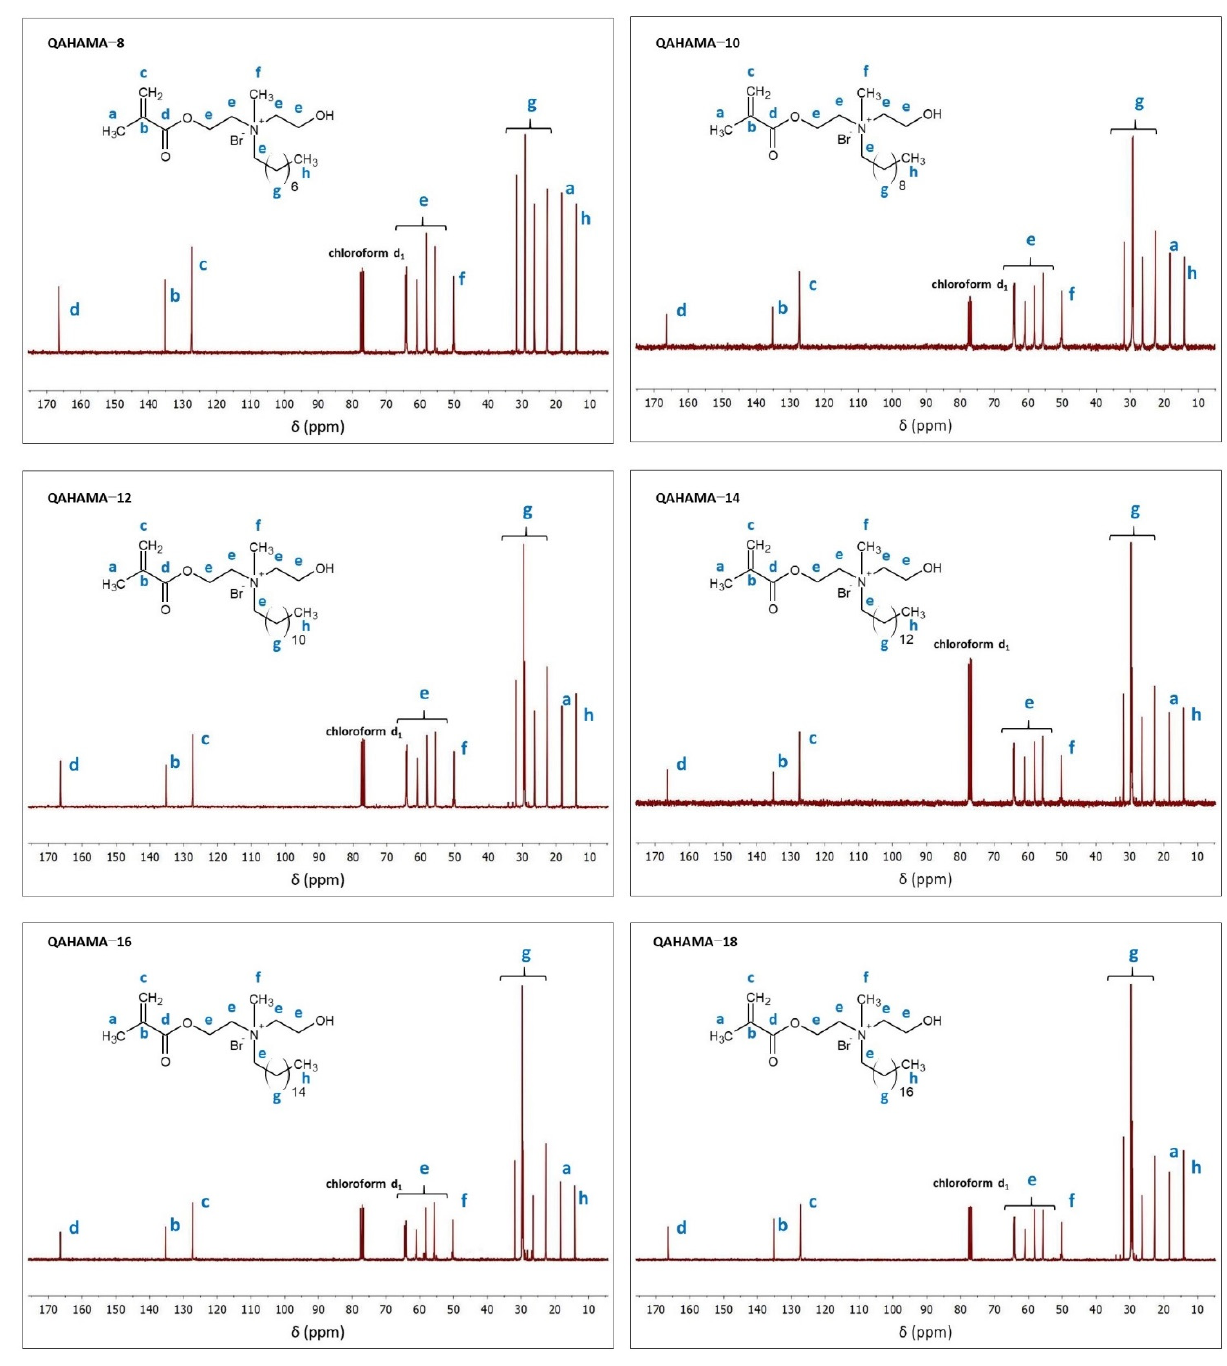
Figure 4. 13 C NMR spectra of QAHAMAs.